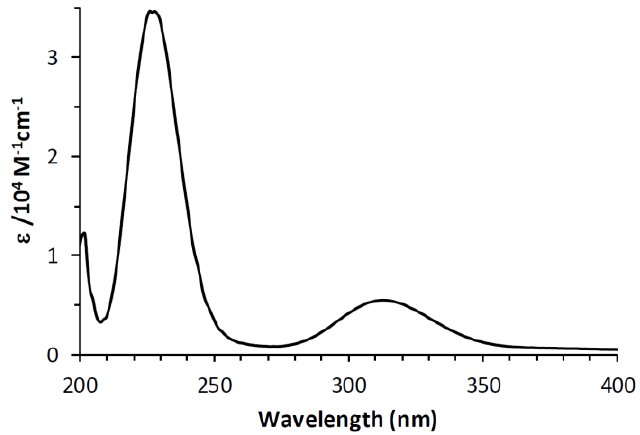
Figure 2. UV-Vis spectrum of HAuCl 4 in 0.1 M aqueous